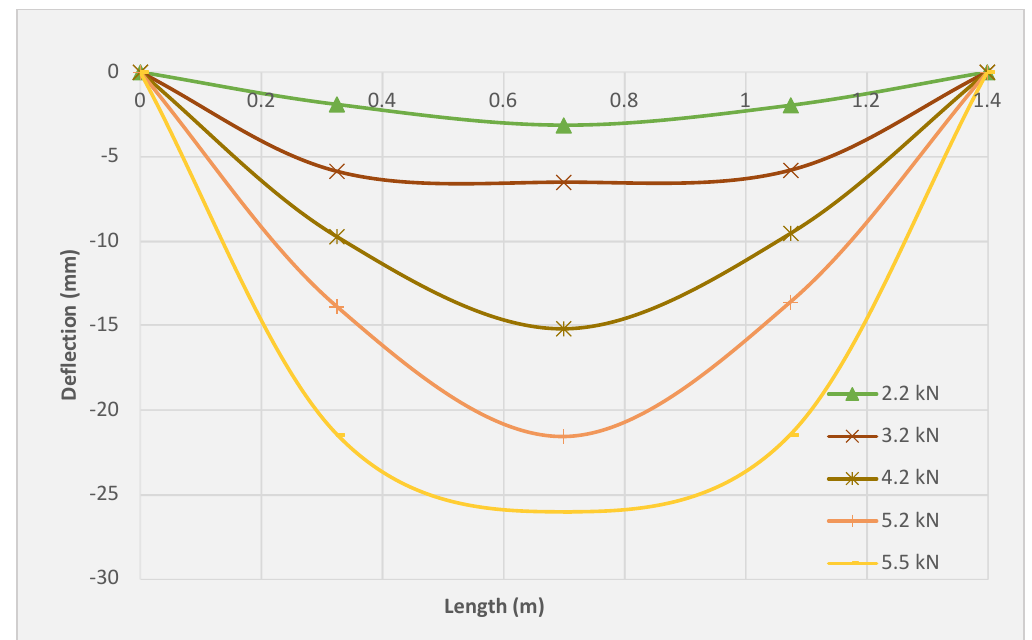
Figure 11. Deflection profile for the SRC tested slab.